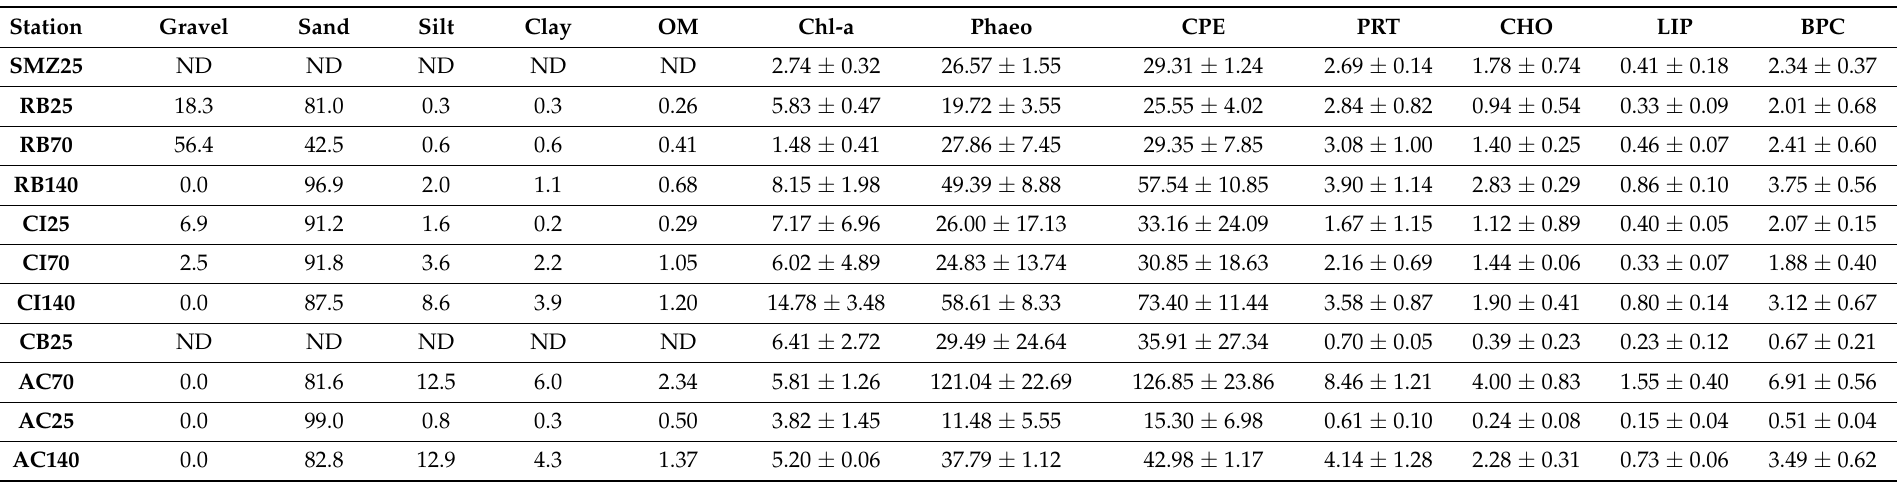
Table 2. Grain size (%) and chemical characteristics of sediment at the 11 sampling stations. OM = organic matter (%), Chl-a = chlorophyll-a ( µ g g − 1